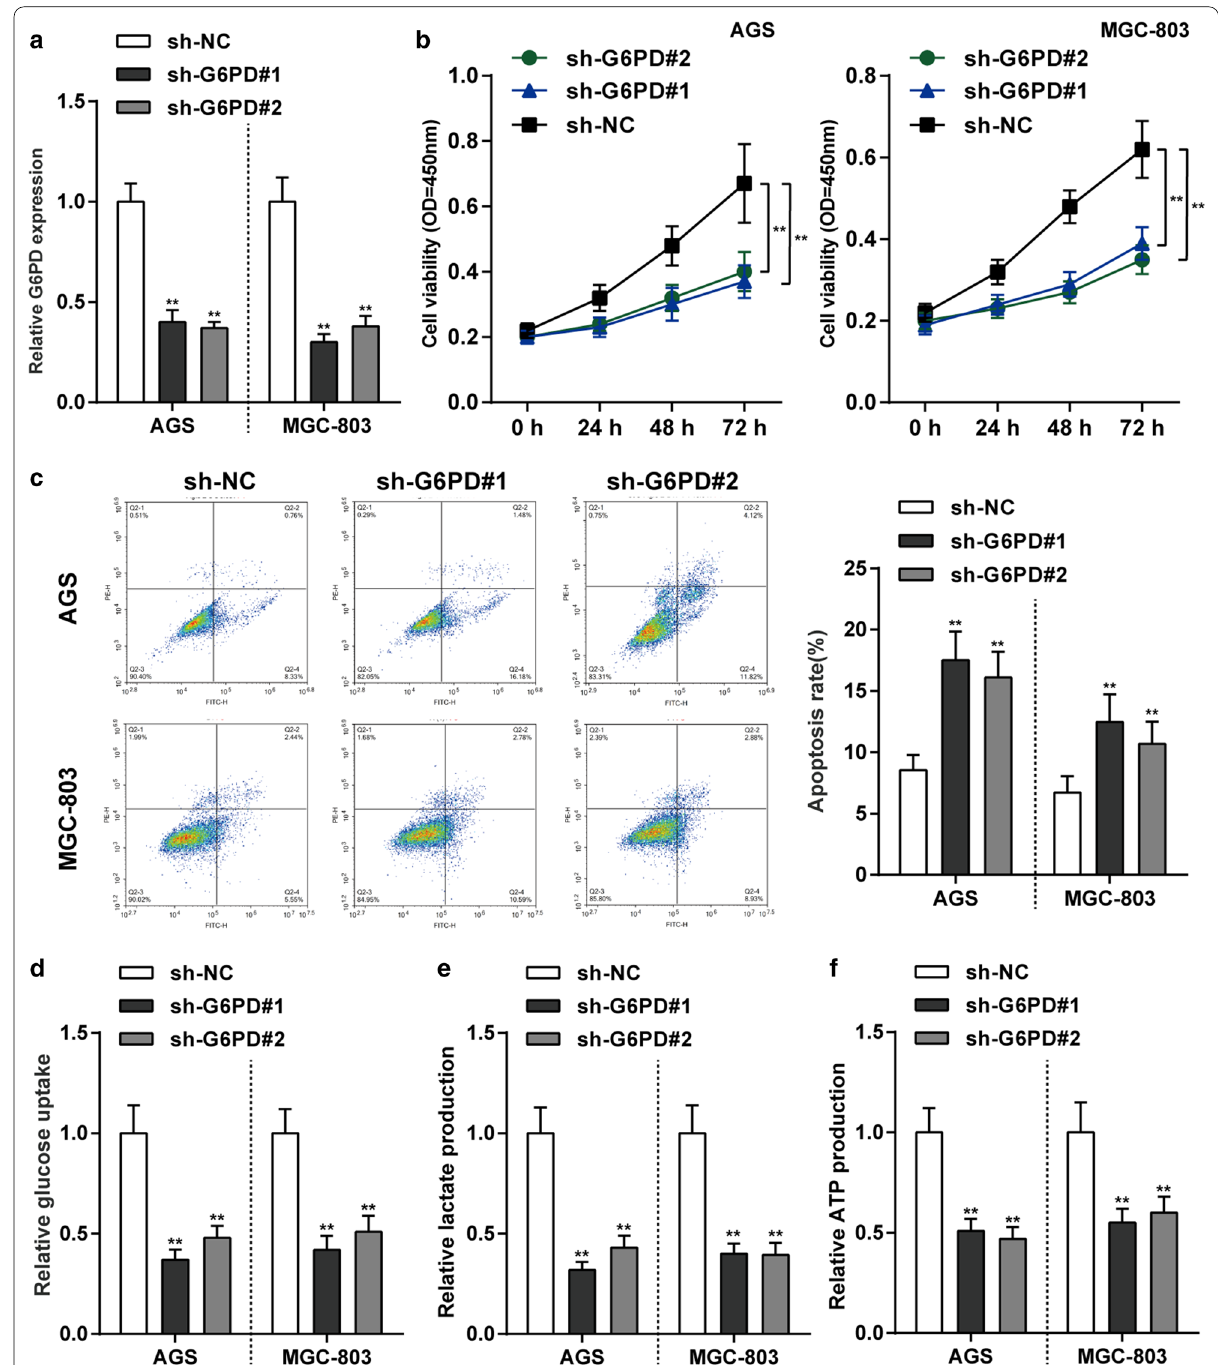
Fig. 2 Effects of G6PD silencing on glycolysis in gastric cancer cells. a G6PD knockdown was achieved in AGS and MGC-803 cells by transfecting short hairpin RNA targeting G6PD (sh- G6PD #1 and sh- G6PD #2). The G6PD mRNA expression level was confirmed by qRT-PCR. b, c AGS and MGC-803 cells were transfected with sh- G6PD #1 and sh- G6PD #2 and examined for cell viability by MTT assay ( b ) and cell apoptosis by Flow Cytometry assay c . d – f Knockdown of G6PD expression significantly decreased glucose consumption ( d ), lactate production ( e ) and ATP production ( f ). N ** P < 0.01 compared to sh-NC